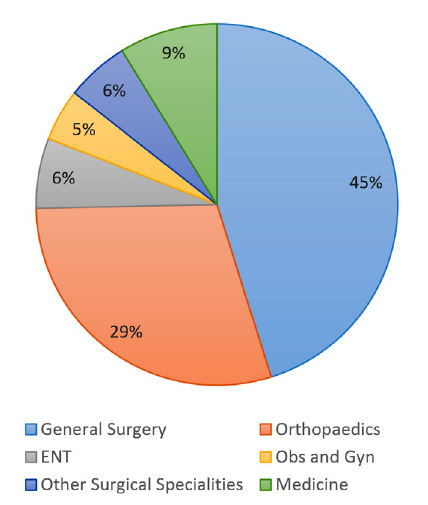
Fig. 2. Ward wise sample distribution